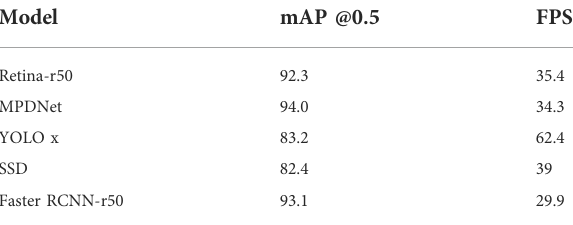
TABLE 3Comparisonof different methodson MetroStation frommAP and FPS.